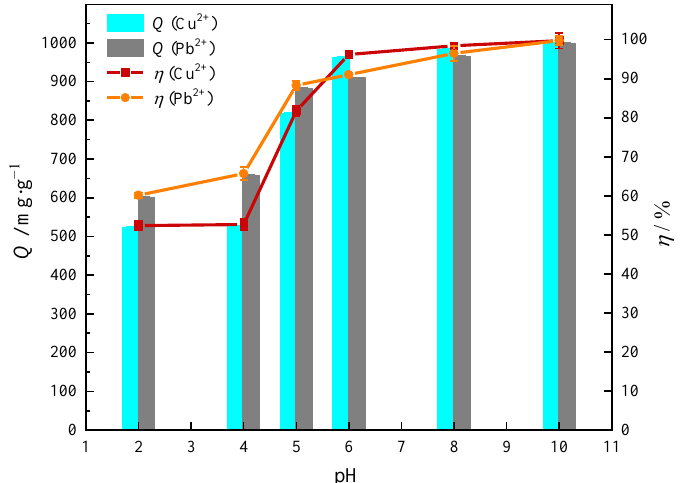
Figure 7. Effect of pH on adsorption capacity and removal efficiency ( C 0 = 1000 mg·L −1 , T = 25 °C, adsorbent concentration = 1 g·L −1 , contact time = 120 min).